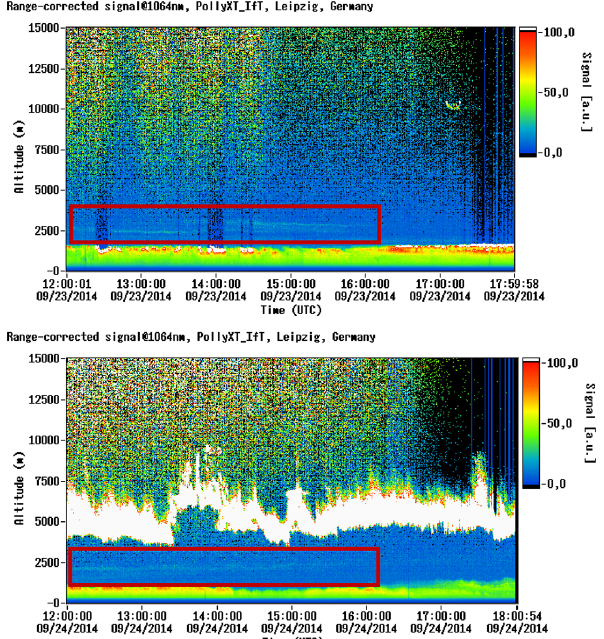
Figure 7. Range-corrected signal at 1064nm from the PollyXT li- dar in Leipzig on 23 (up) and 24 September 2014 (down). The red rectangle indicates the location of the volcanic ash layer.